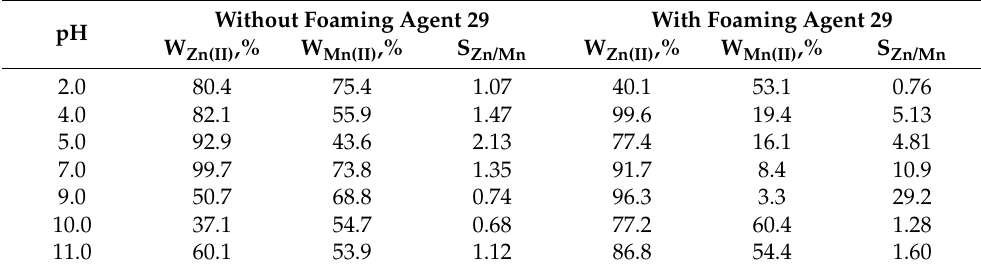
Table 4. Results of Zn(II) and Mn(II) flotation using collector 32 in a 10 min process with and without foaming agent 29 at a pH from 2.0 to 11.0; (Zn) = 0.00168 M, (Mn) 0.00091 M, (32) = 5.0 × 10 − 3 M, (29) = 2.0 × 10 − 4 M. Without Foaming Agent 29 With Foaming Agent pH